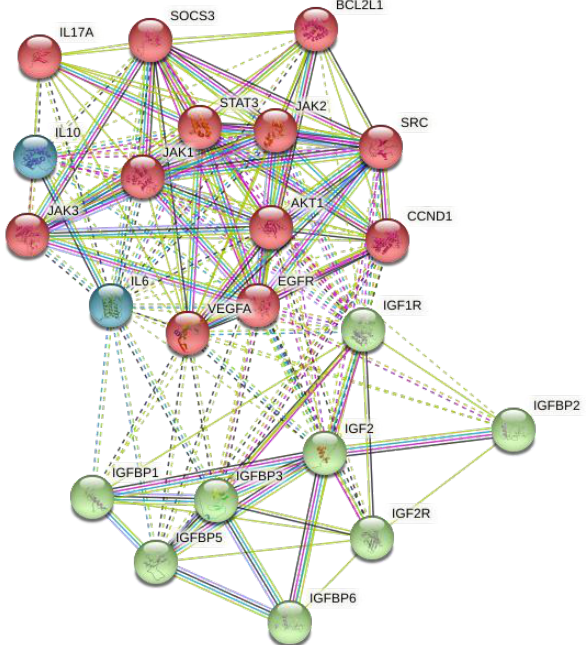
Figure 5. STRING network (default k-means clustering method) performed by the introduction of STAT3 and IGF2 (both modulated by miR-93-5p) with 20 interactors.